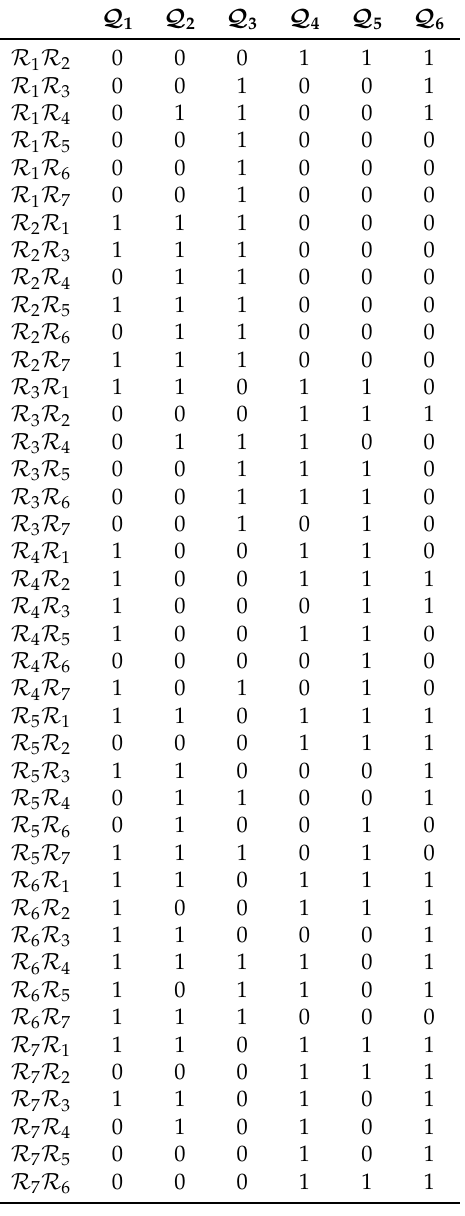
Table 13. Usual criterion preference